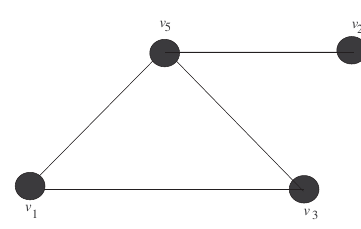
Figure 3. F ( Γ ) > m ( Γ ) − 1, but G ( Γ ) has a